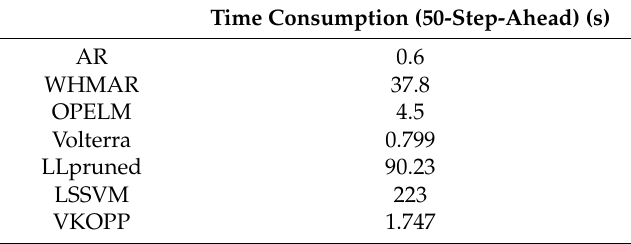
Table 9. The time consumption of several prediction algorithms for experimental dataset of